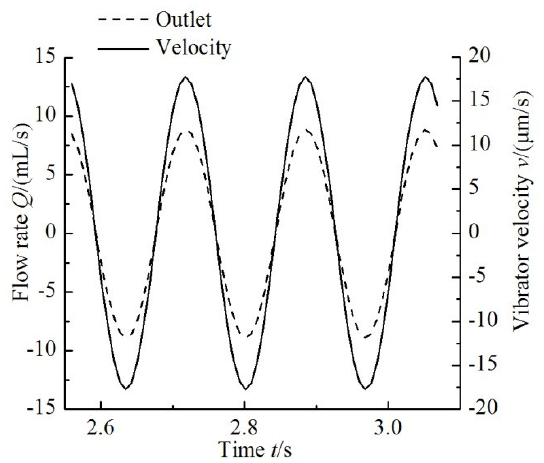
Figure 11. Curves of flow rate and vibrator velocity.